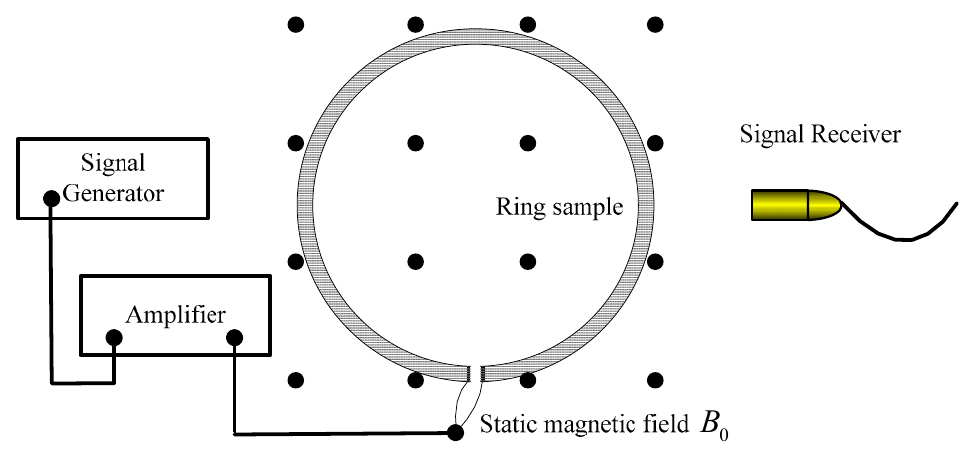
Figure 1. Magnetoacoustic coupling effect.